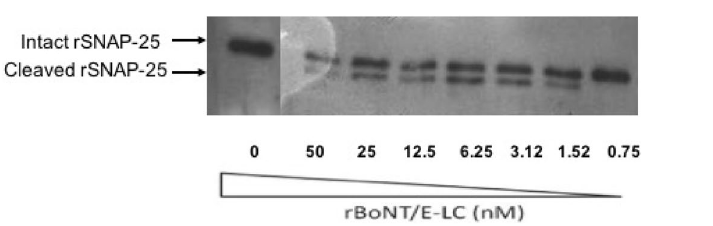
Figure 1. Expression, western blot and purification profile of rBoNT/E-LC ( A ) SDS-PAGE profile of rBoNT/ E-LC, ( B ) Western blot profile of rBoNT/E-LC probed with anti His HRP-labelled antibody: lane M: Molecular weight marker; lane 1: uninduced pellet; lane 2: induced pellet; lane 3: supernatant after sonication; lane 4: pellet after sonication. ( C ) Purification profile of rBoNT/E-LC Lane M: Molecular weight marker; lane 1: uninduced pellet; lane 2: induced pellet; lane 3: supernatant after sonication; lane 4: pellet after sonication; lane 5: flow through; lane 6–7: washes; lane 8–12: protein elutes, and lane 13: 1 M imidazole.